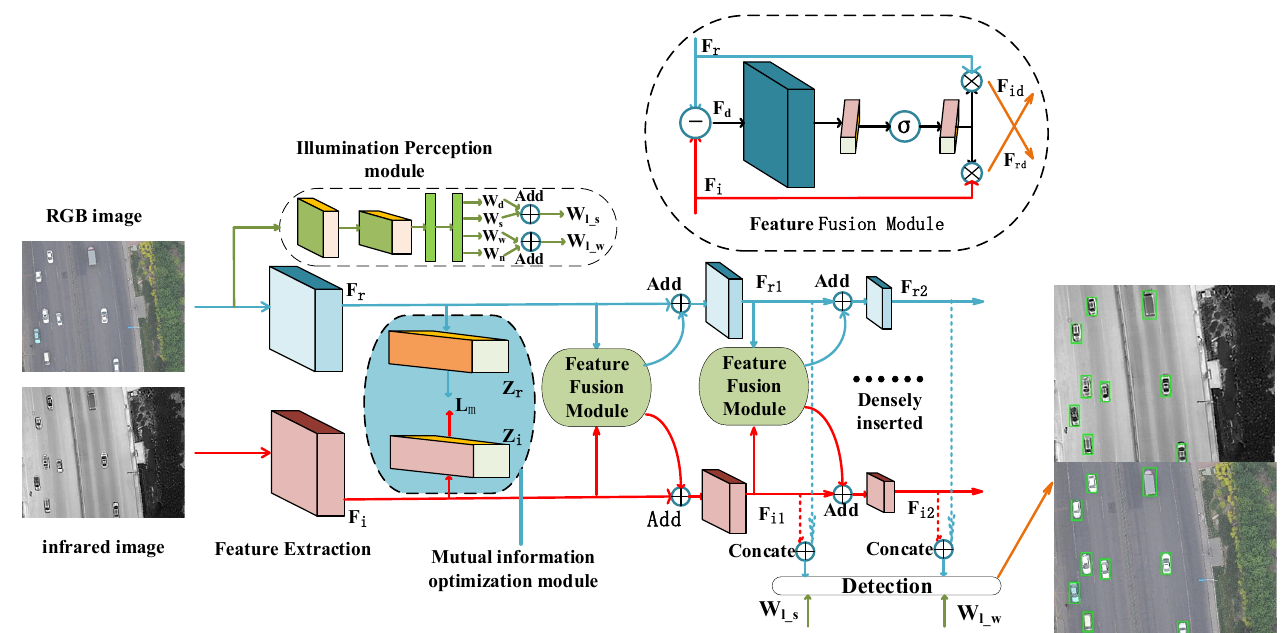
Figure 1. Overview framework of the proposed redundant information suppression network (RISNet). The RISNet consists of four parts: feature extraction stage, mutual information measurement module, feature fusion module and detection stage.